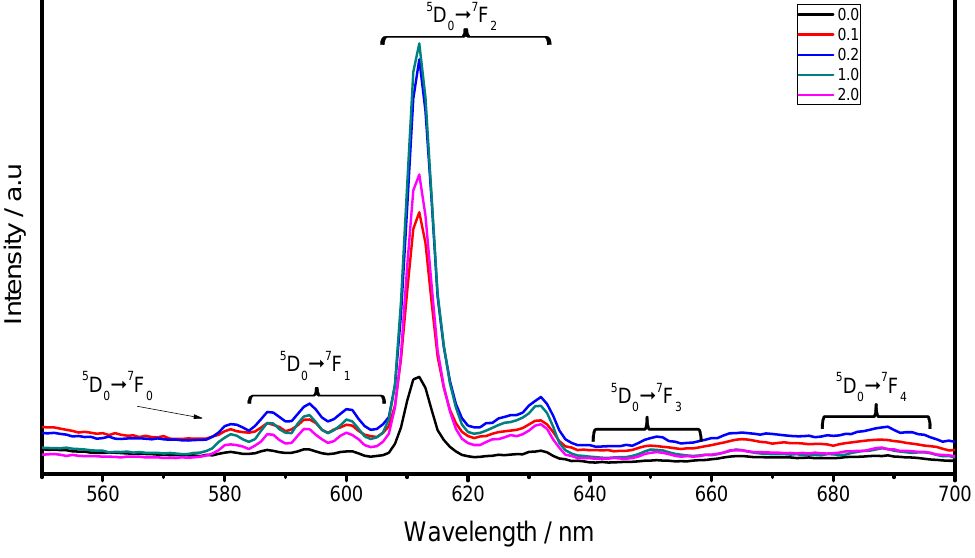
Figure 9. Emission spectra ( λ function of F127/Lu molar ratio at annealing temperature of 1073